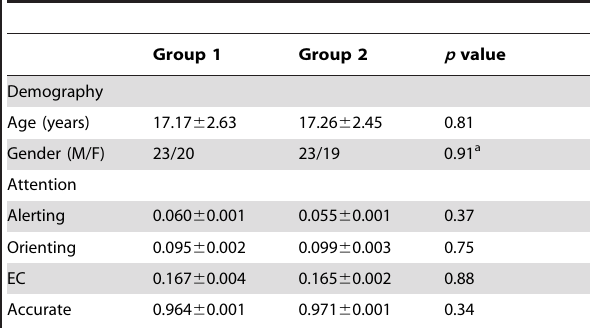
Table 2. Demographics and attentional performance of the two groups.